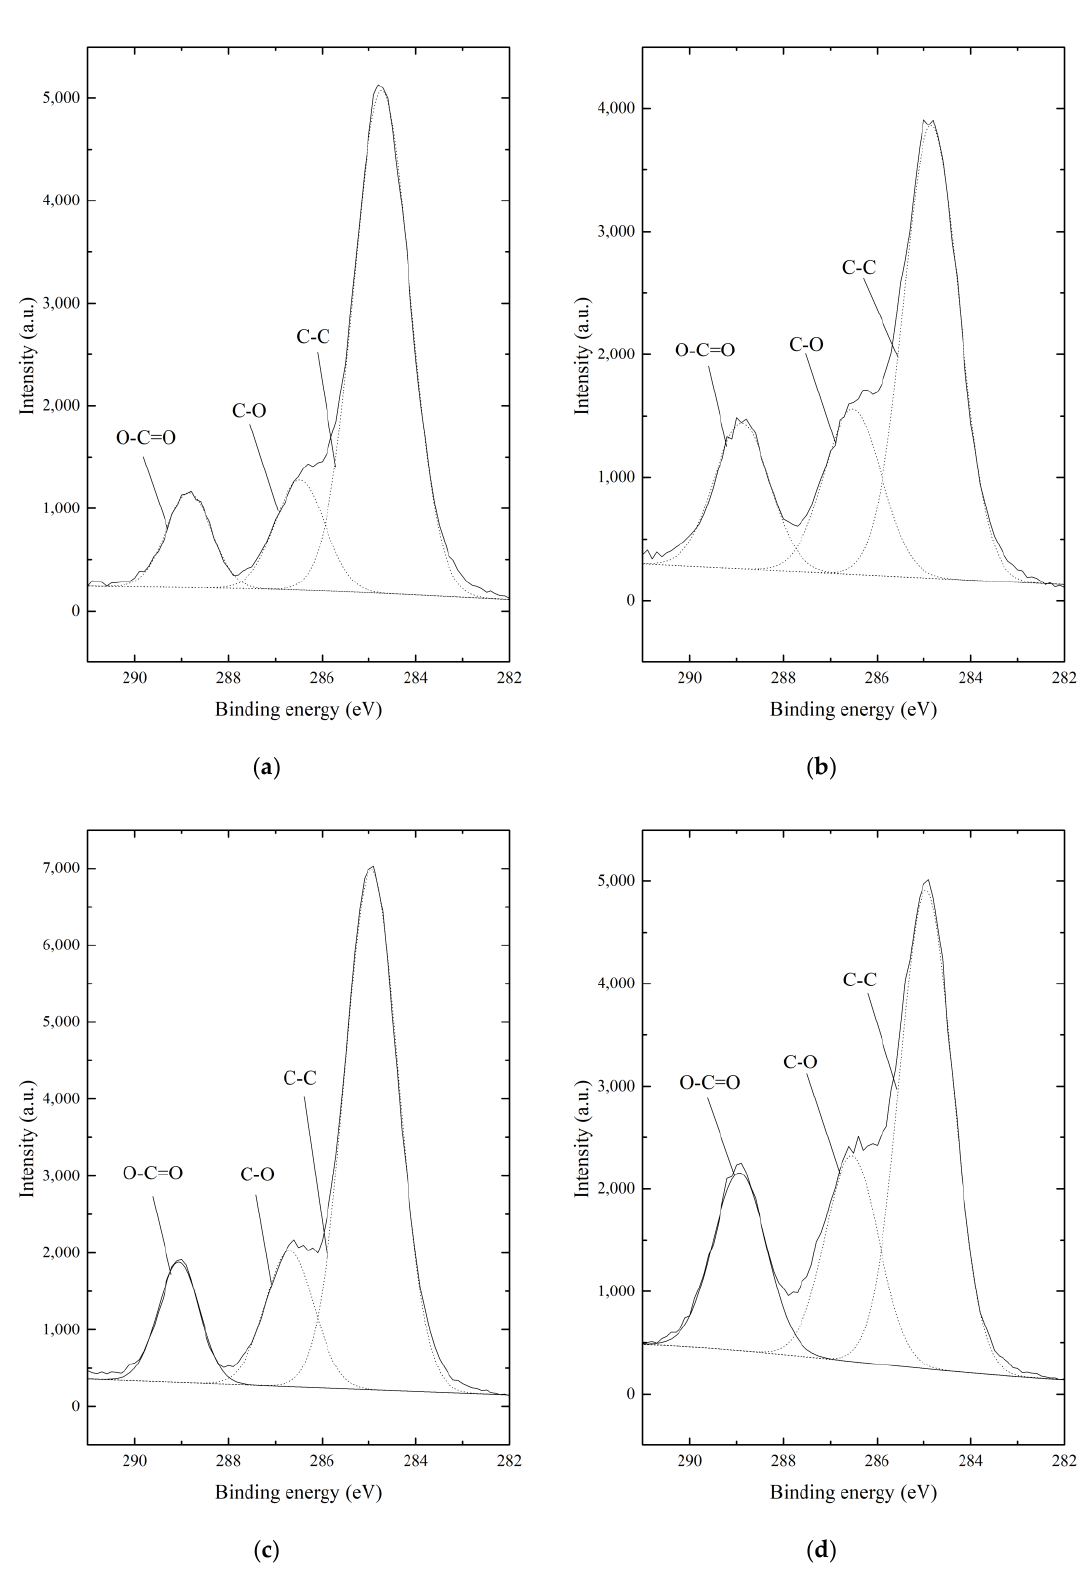
Figure 12. C1s spectra of the PET surface after being treated by ( a ) none, ( b ) APPJ only, ( c ) sanding only, and ( d ) both sanding and APPJ.